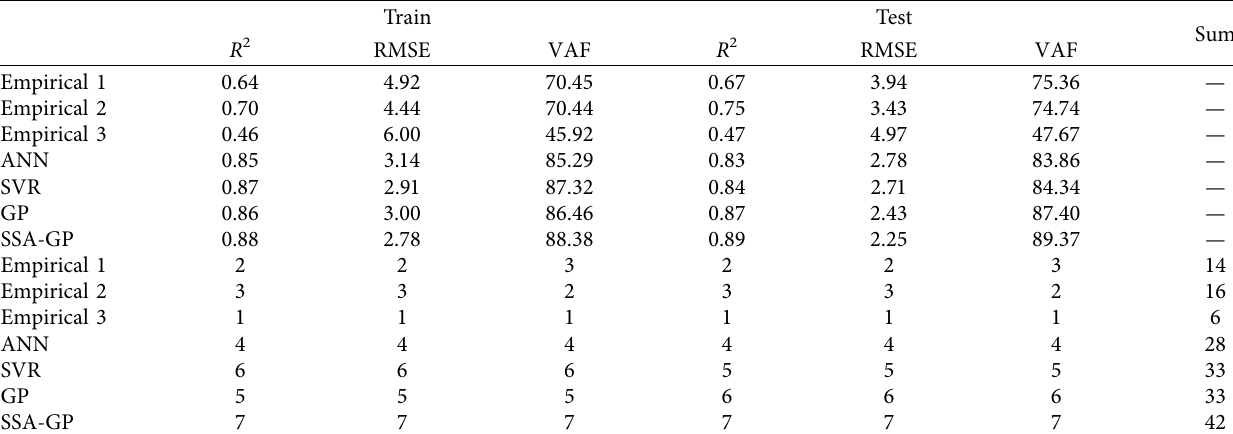
Figure 5: Errors between measured and predicted PPV values. Table 1: Model performance of various